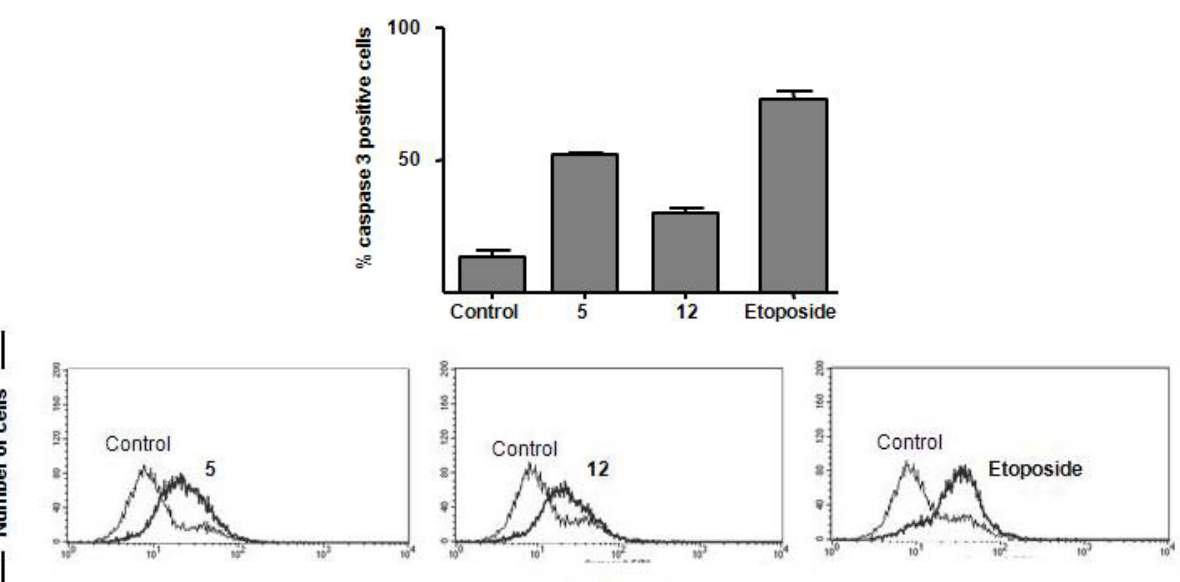
Figure 4. Impact of compounds 5 and 12 on caspase-3 activation. Jurkat cells were treated with compounds for 18 hours and labeled with anti-caspase 3 FITC, following flow cytometric